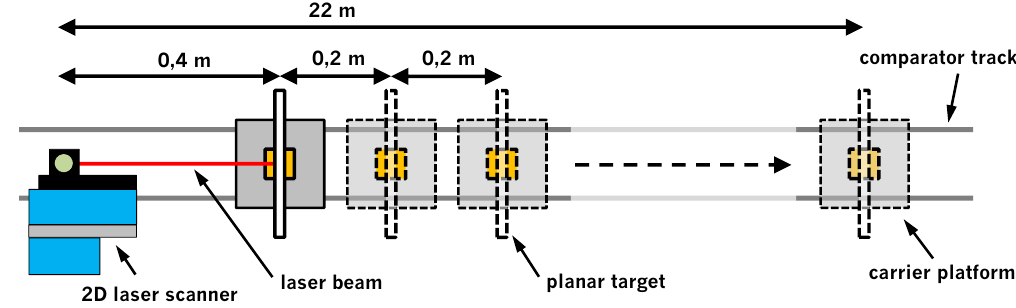
Figure 3. Setup for the investigation of the precision of the distance measurements of the Z + F Profiler 9012A on a railbound comparator track by scanning planar targets at different distances.